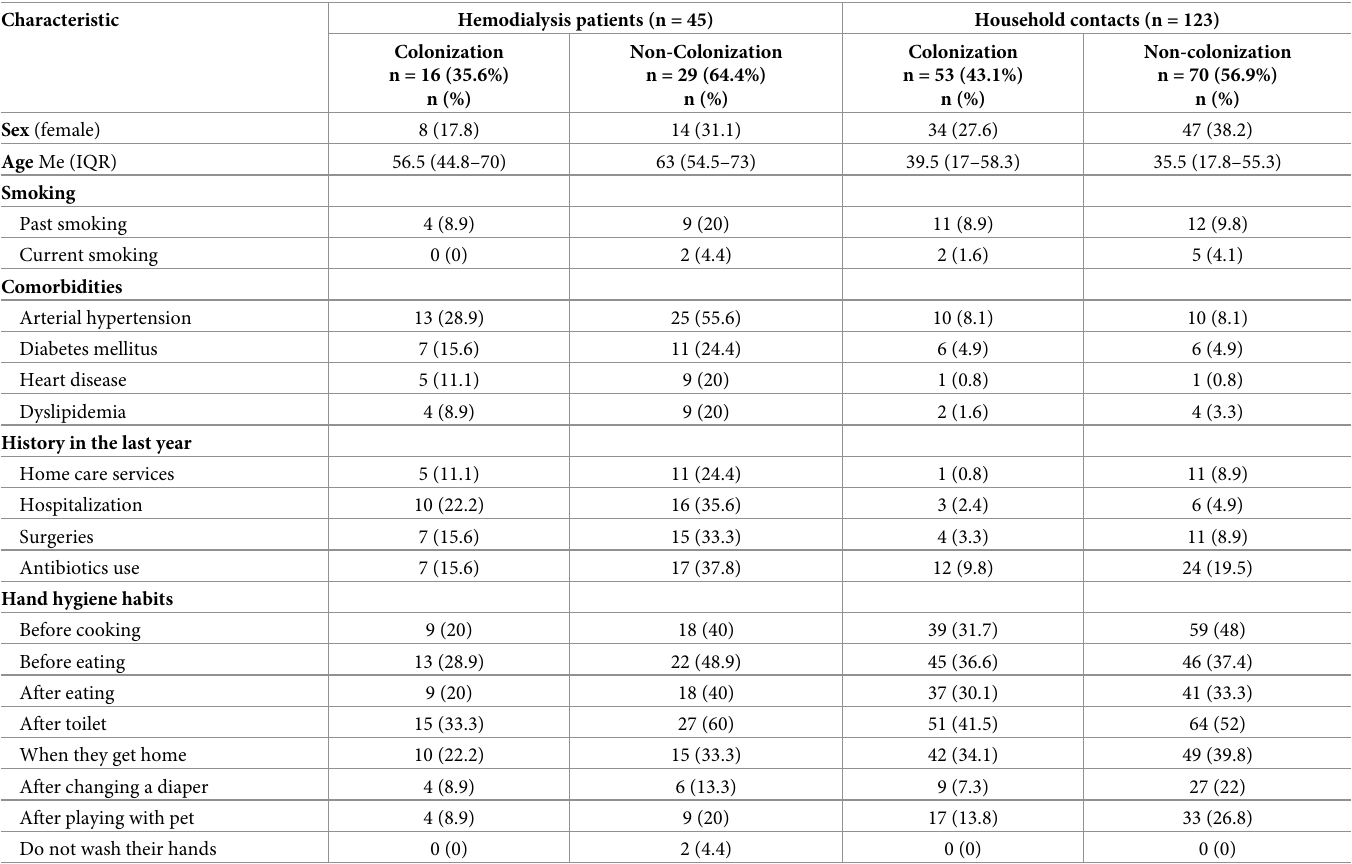
Table 1. The clinical and epidemiological characteristics of hemodialysis patient and their household contacts according to colonization status by S . aureus